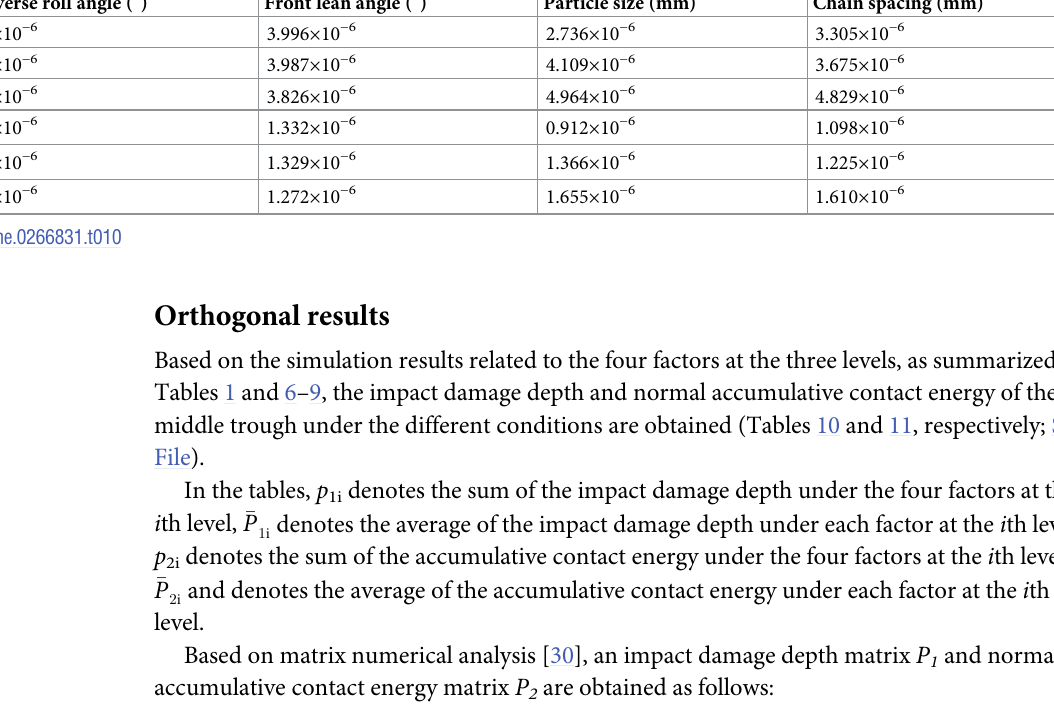
Table 10. Impact damage depth (mm) under the different conditions.